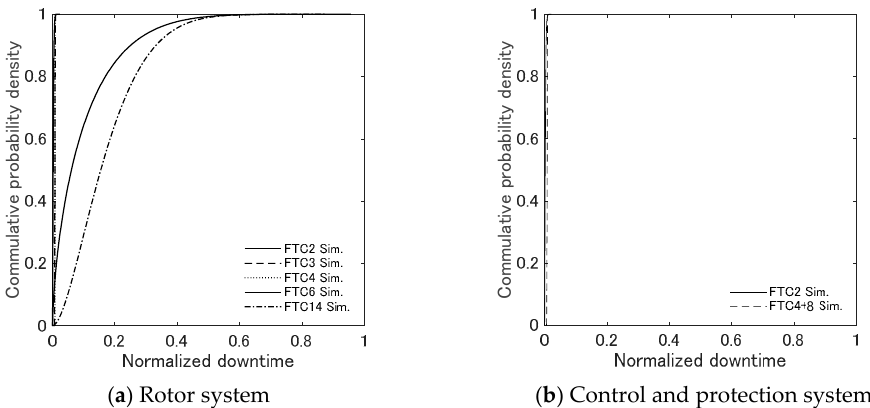
Figure 11. Cumulative distribution of downtime for Scenario 2.